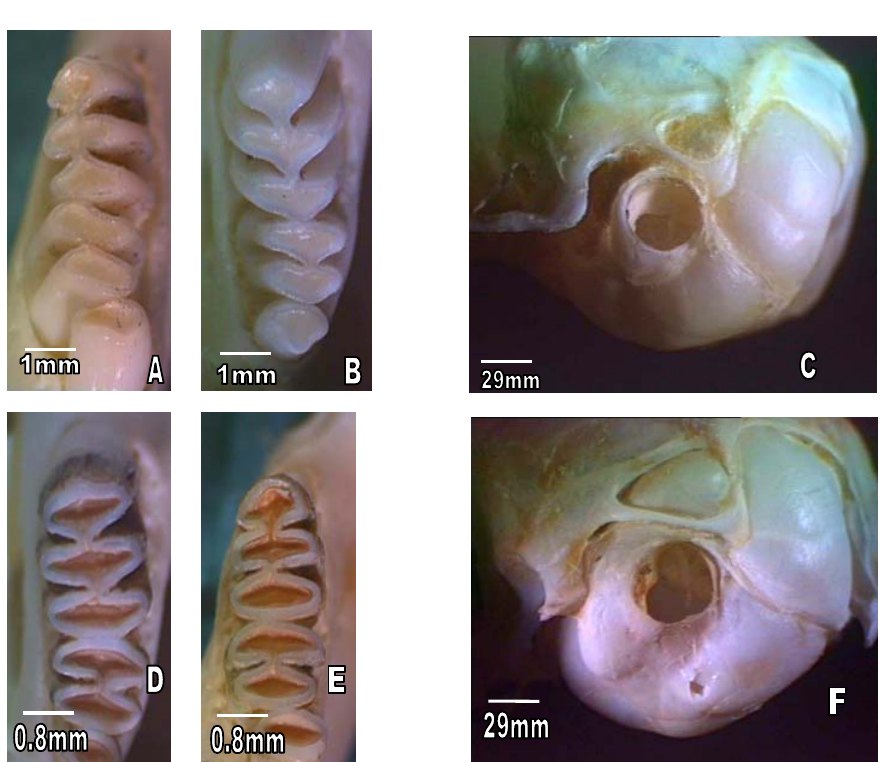
F IG . 2.- Cheek teeth row in M. persicus (A and B), and M. libycus (D and E) and tympanic bullas of M. persicus (C), and M. libycus